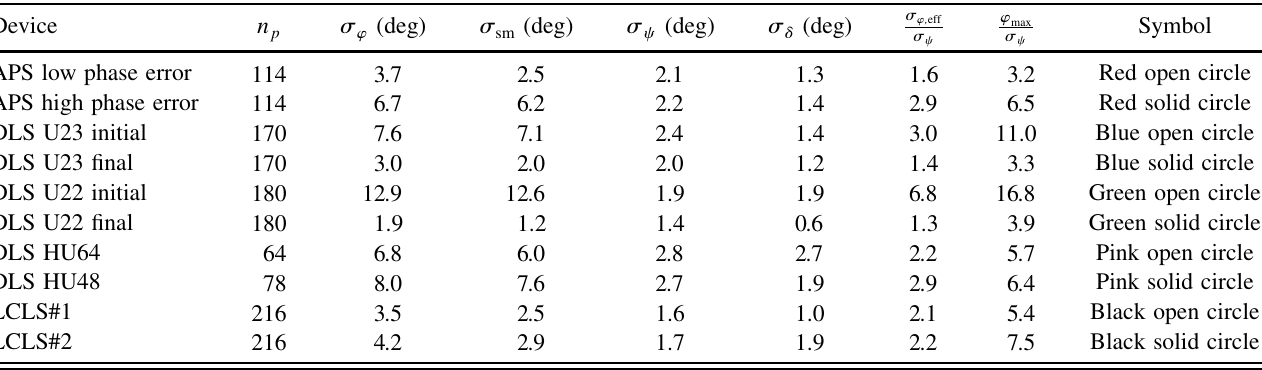
TABLE I. Characteristics of the phase errors for the ten different cases that have been studied. See text for details. Device